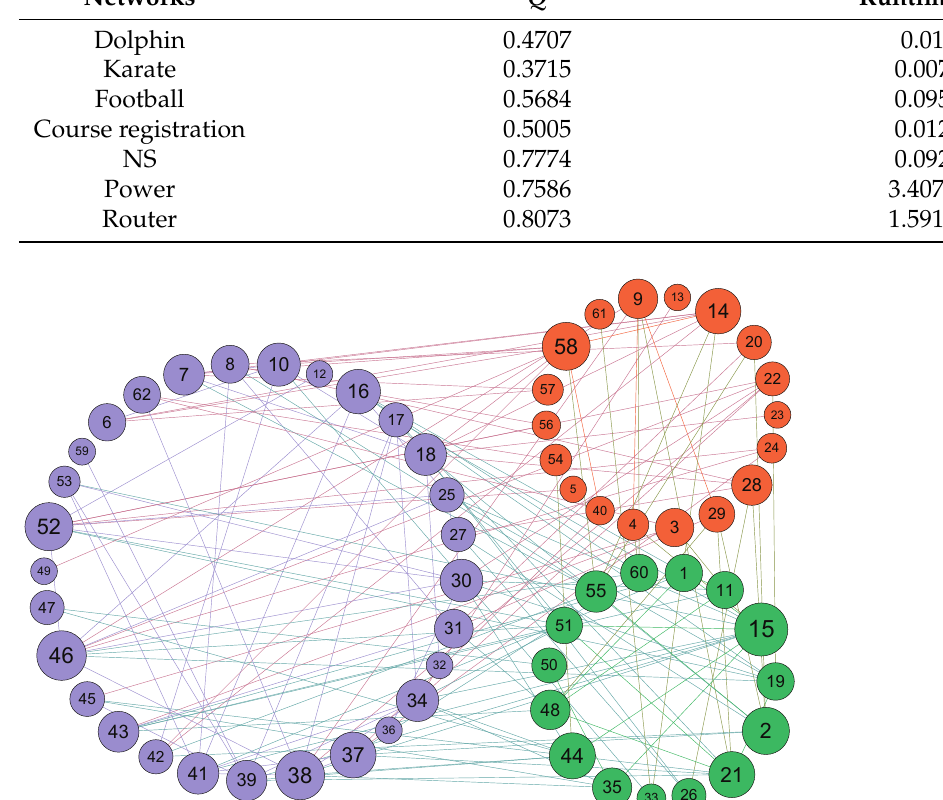
Figure 3. The final community structure of Dolphin according to the NINS algorithm.